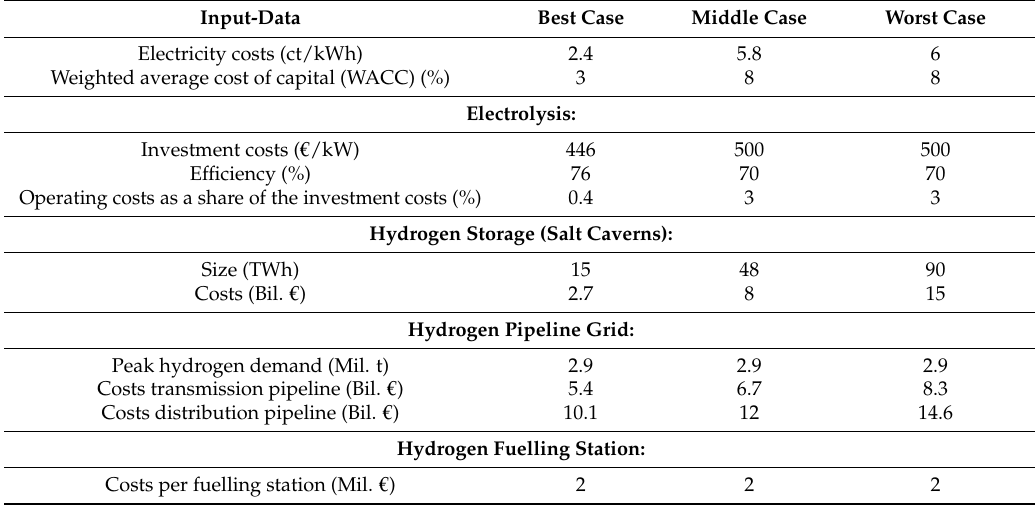
Table 2. Input values of pre-tax hydrogen cost analysis of the updated energy concept from the IEK-3, compare Figure